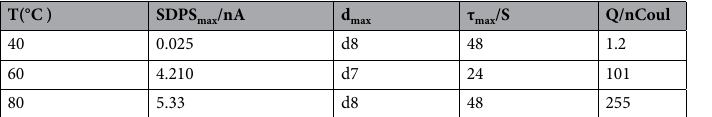
Table 3. The time scales of the predominant transients of SDPS plots corresponding to Asy copper electrodes in 0.3 M NaCl + 0.3 M Na 2 SO 4 at 40, 60 and 80 °C.